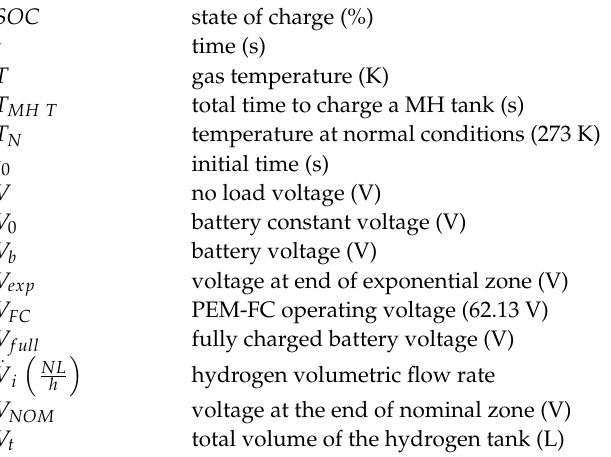
Table A3. Commercial examples of Redox Flow Batteries. Data provided by the manufacturer.